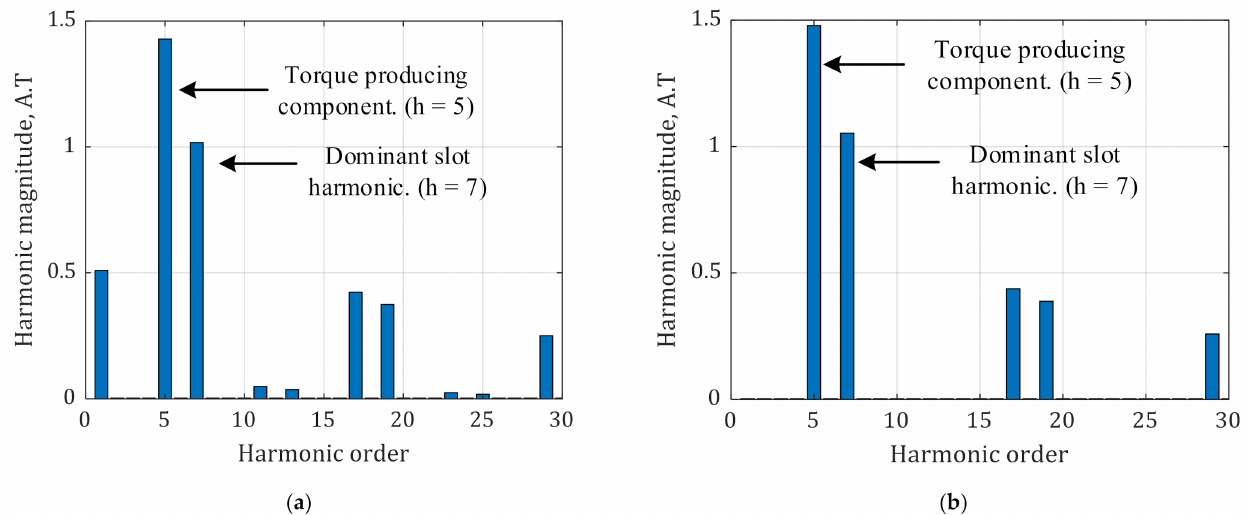
Figure 3. Magnetomotive force (MMF) harmonic spectra for six-phase 12-slot/10-pole SPM winding arrangements under propulsion mode: ( a ) Dual three-phase and ( b ) asymmetrical